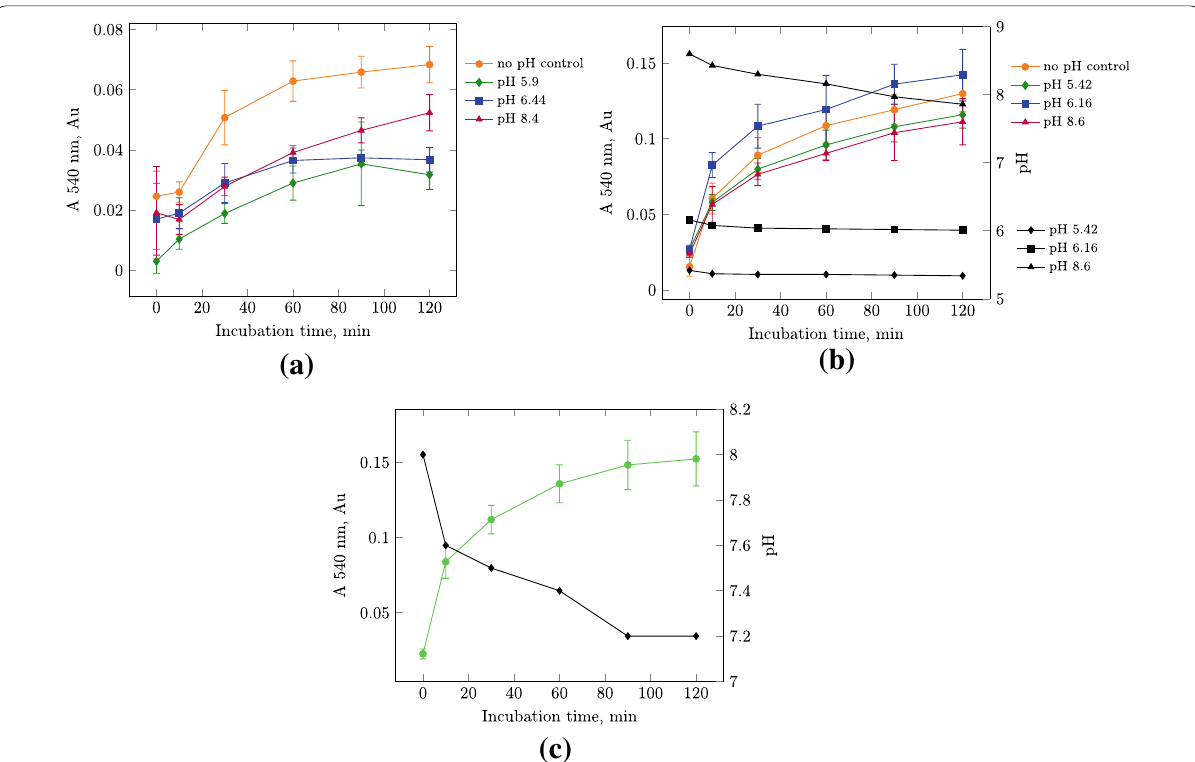
Fig. 2 Kinetic dependence of the TCA-soluble peptides accumulation on the pH of the reaction mixture during the enzymatic hydrolysis of soy protein isolate (SPI) under the action of protosubtilin. a On a laboratory scale; b on a semi-industrial scale with buffer systems; c on a semi-industrial scale with water (11.9 units per 1 g of SPI, 40 ◦ C). Changes in the pH of the reaction mixture during the reaction in buffer system are shown by the black